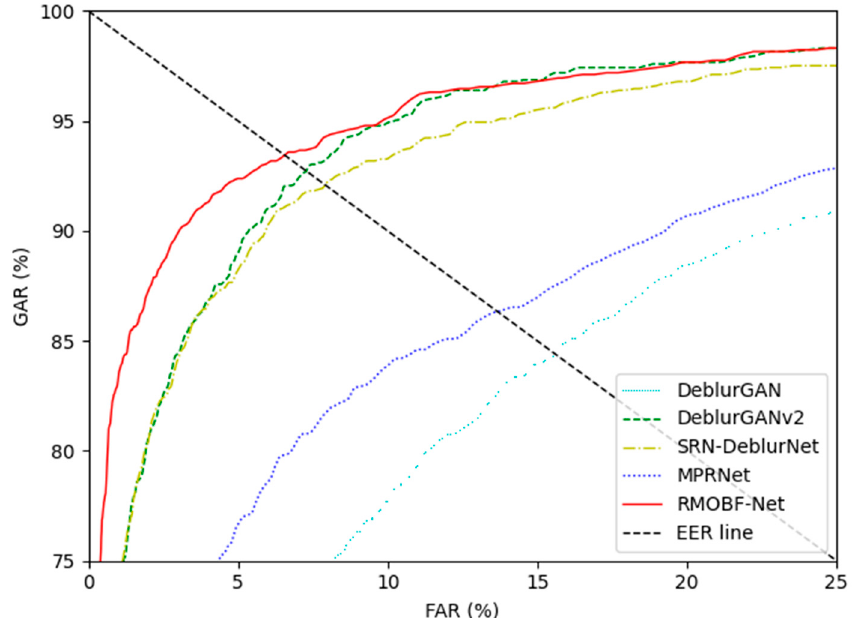
Figure 35. ROC curves of finger-vein recognition with PolyU-DB for scheme 5 by various restoration methods (random motion blur and optical blur with intensity 19 × 19 (Gaussian filter size) and 19 (Gaussian filter standard deviation)).